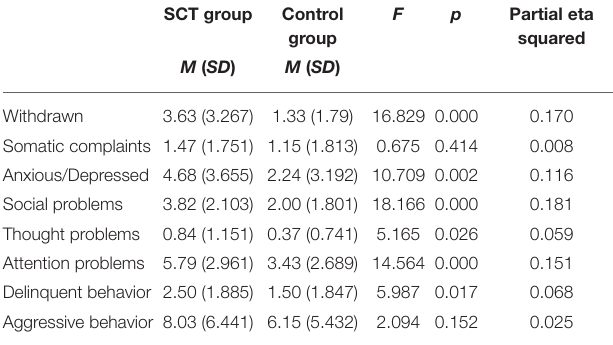
TABLE 1 | Mean and standard deviation of the CBCL subscale scores in the SCT and control groups.